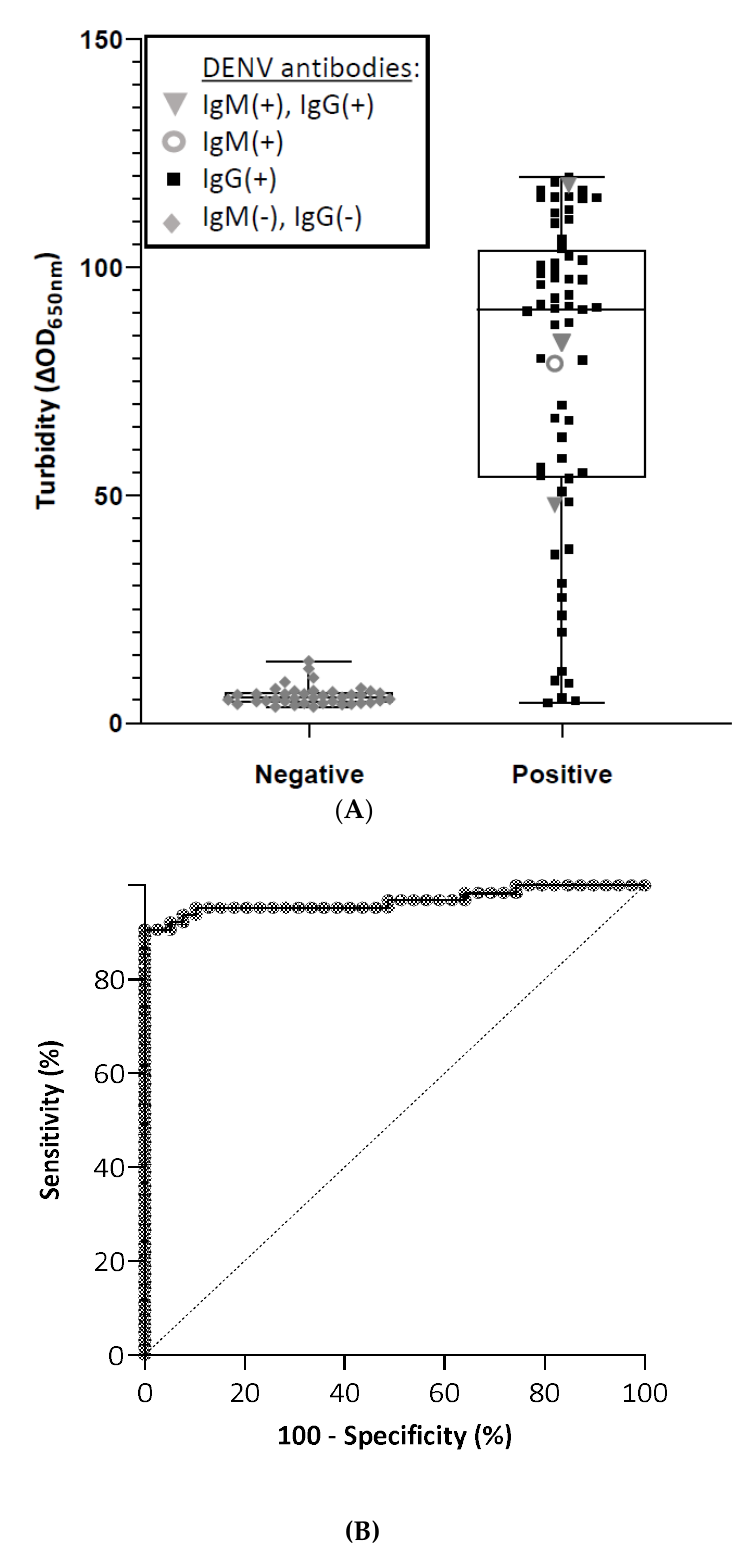
Figure 3. Performance of the immunological MFEA readout at detecting anti-DENV antibodies. ( A ) Scatterplots of the turbidity signal obtained in plasma samples classified as negative or positive for the presence of anti-DENV antibodies. Data are expressed as median turbidity signals with interquartile ranges. ( B ) Receiver operating characteristics (ROC) curve. The plot of True-Positive Fraction (sensitivity %) (true-positive samples/true-positive plus false-negative samples) vs. False-Positive Fraction (100 − specificity %) (false-positive samples/false-positive plus true-negative samples) generates the ROC curve. AUC: area under the ROC